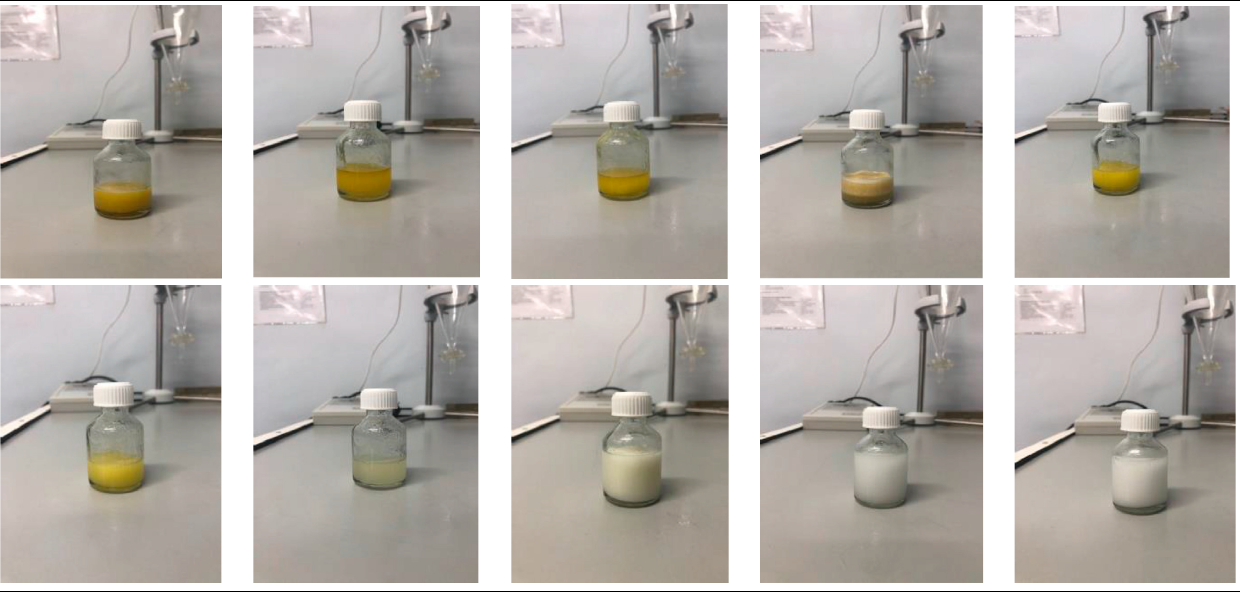
2 extract of safflower ( Carthamus tinctorius L.) .